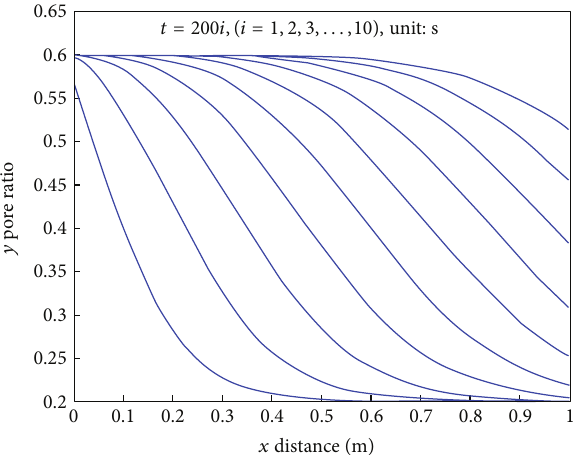
Figure 5: Changing of pore ratio along the path over time 𝑥 ( m ) , 𝑦 pore ratio.